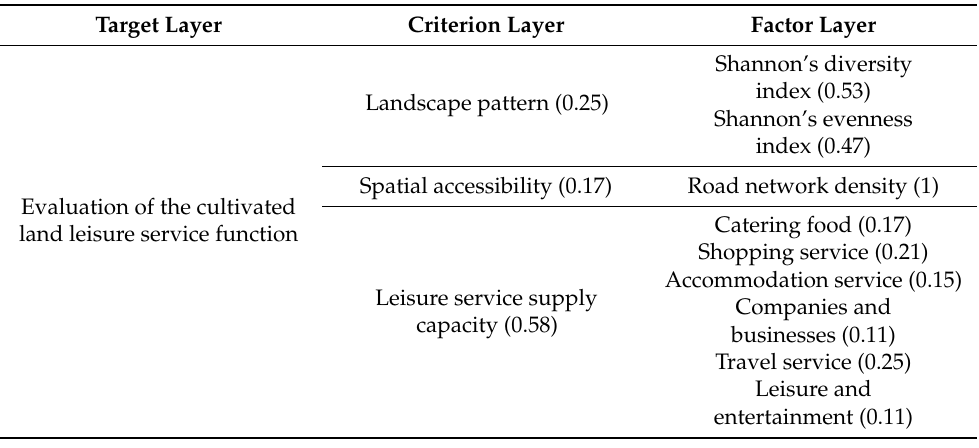
Table 2. Weight of the cultivated land leisure service function